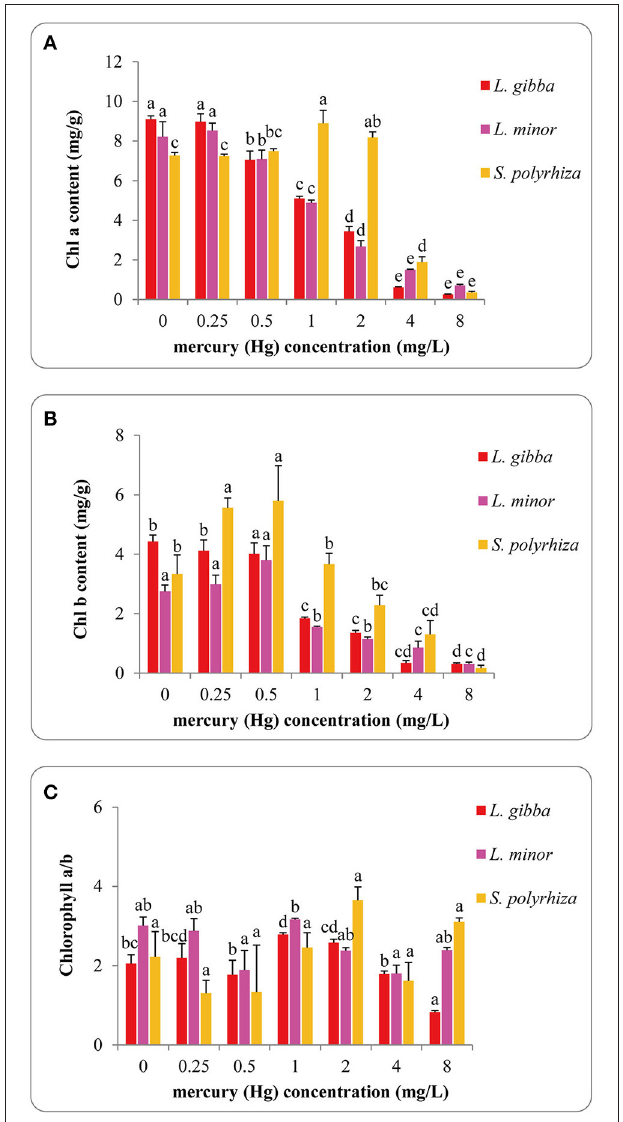
FIGURE 4 | Effects of different concentrations of Hg on the content of Chlorophyll a (A) , Chlorophyll b (B) and Chlorophyll a/b (C) of three duckweed lines. The pigment content was measured after 7 days Hg treatment and calculated based on the fresh weight (FW). The letters (a, b, c, d, e) on the column graphs indicated Tukey tests analyses results among different Hg treatments in the same duckweed. The same letters indicated no significant differences and different letters indicated significant difference among treatments. Error bars indicated standard deviation.